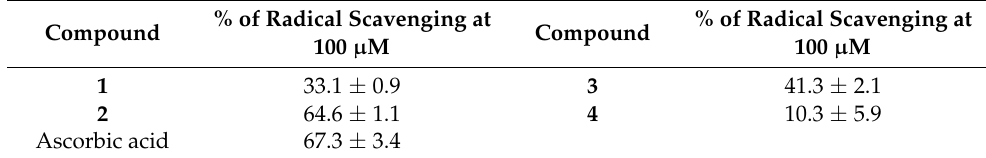
Table 1. DPPH radical scavenging activity of investigated